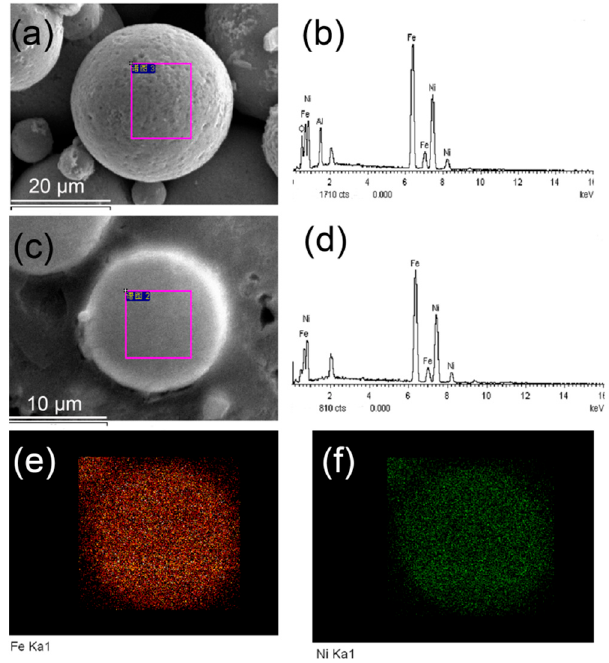
Figure 3. SEM morphology and energy dispersive spectrometer (EDS) of the pherical alloy particle for ( a ),( b ) surface ( c ),( d ) cross-section ( e ),( f ) elemental mapping of cross-section. Table 1. Composition ratios of Fe and Ni in the spherical alloy sample.